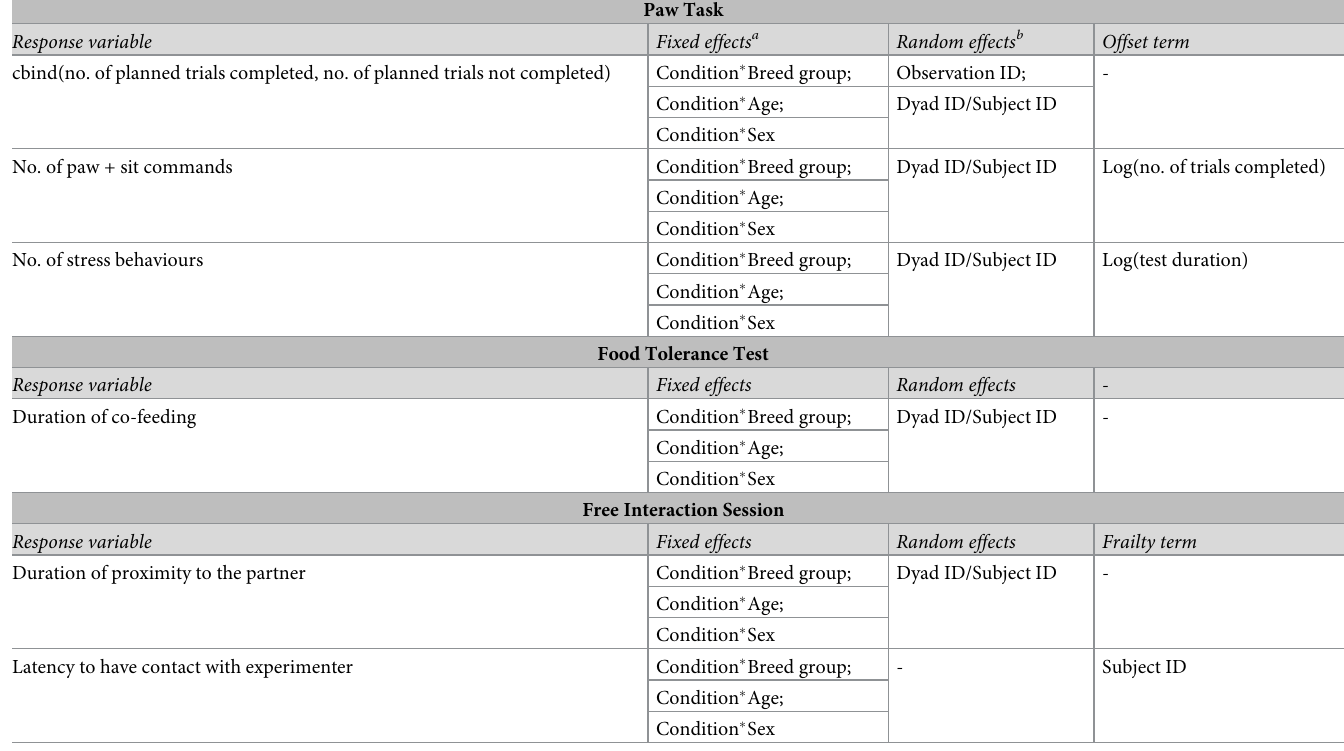
Table 2. Summary of response variable, fixed effects, random effects, offset term, and frailty term included in each model.